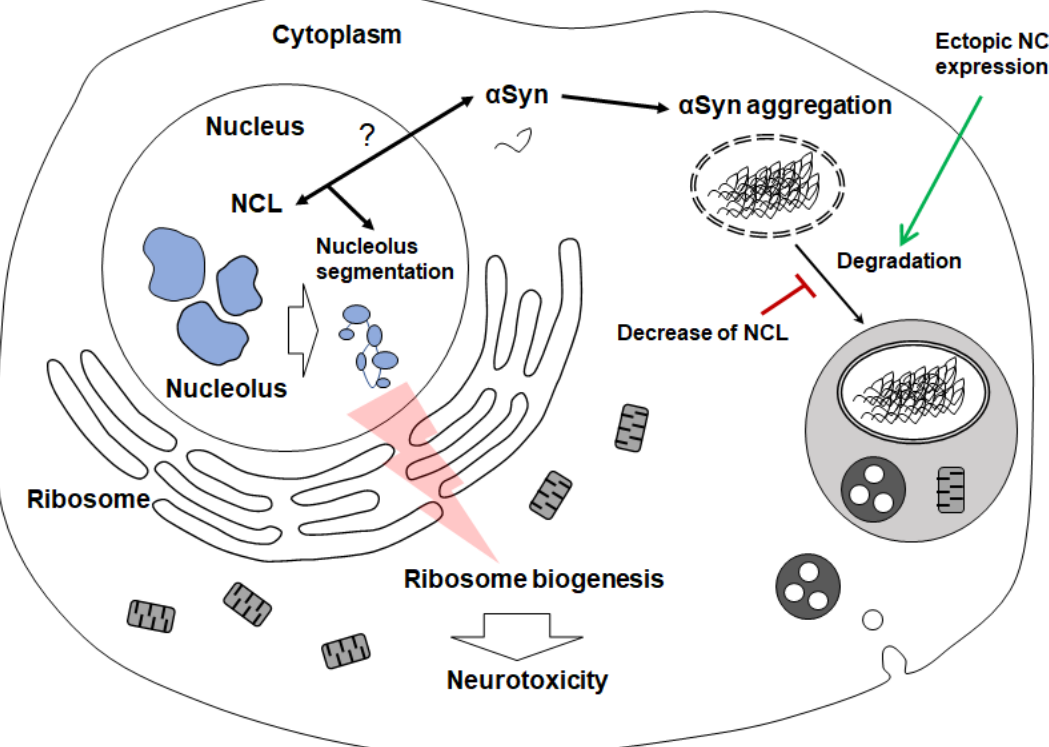
Figure 7. The graphical summary. Unlike most α Syn that accumulates in the cytoplasm, some α Syn that migrates to the nucleus might interact with NCL, resulting in the segmentation of nucleolus. Therefore, the disruption of nucleolar conformation could affect ribosome biosynthesis, thereby mediating neurotoxicity. The degradation of α Syn would be accelerated by the ectopic expression of NCL and repressed by the decrease in NCL. Question mark indicates the interaction between NCL and α Syn in the nucleus.